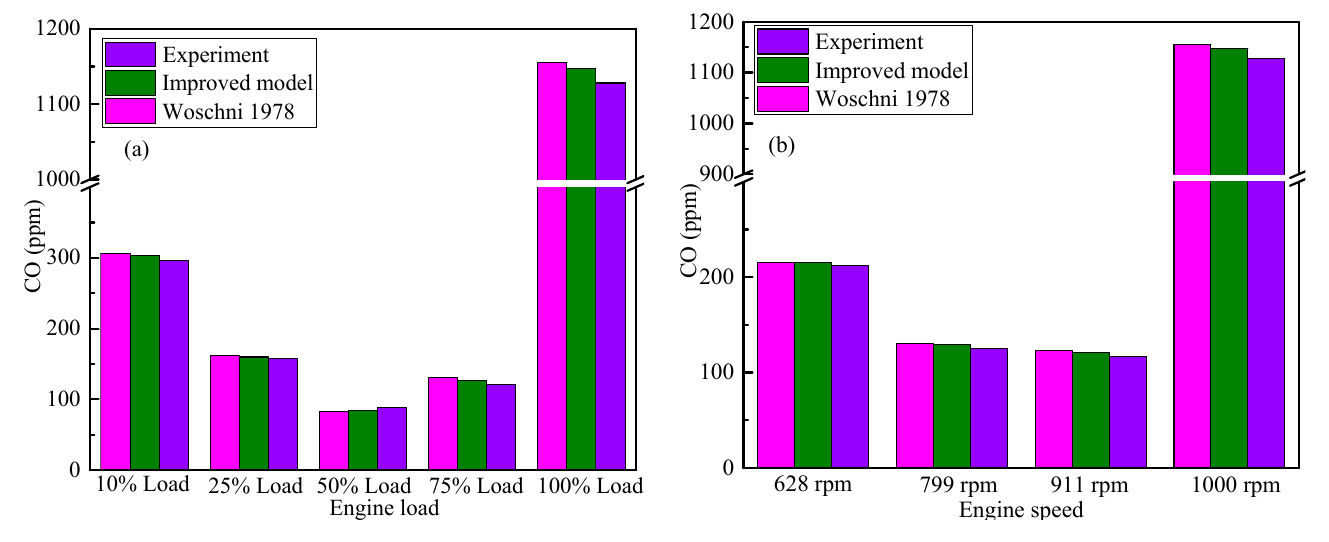
Figure 10. Comparisons of CO emission under different load conditions.